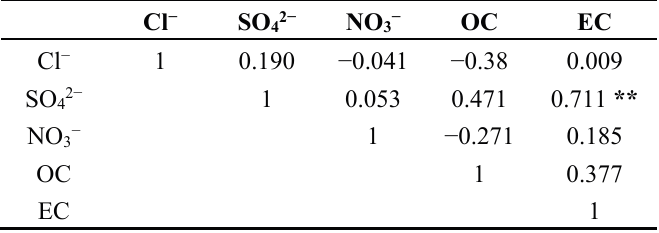
Table 6. Inter-species correlation